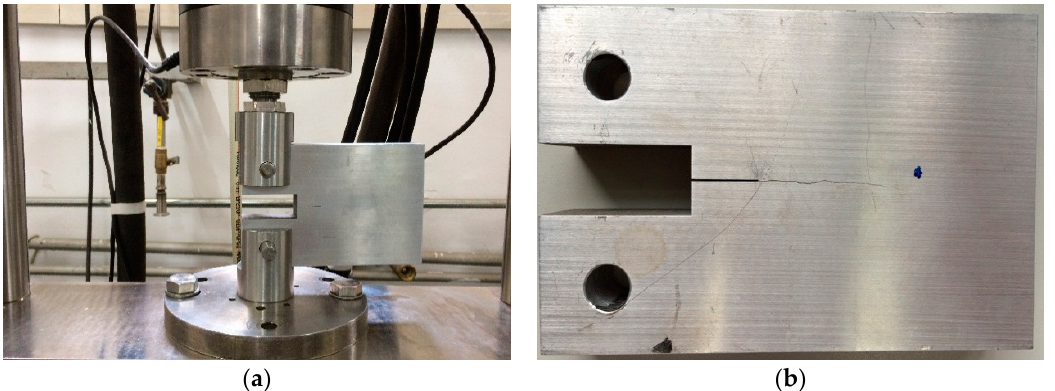
Figure 6. ( a ) The fatigue test. ( b ) The fatigue sample with a crack.